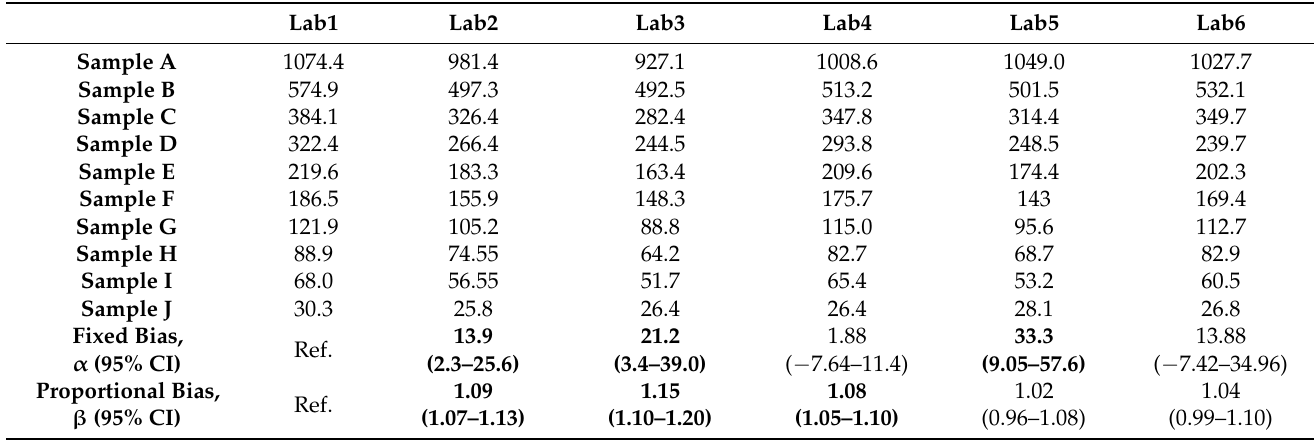
Table 2. Measurement of the calibration curve common to all diagnostic instrumentation. Fixed and proportional biases are expressed as alpha and beta coefficients and their 95% CI. Sample measurements are expressed in pmol/L.